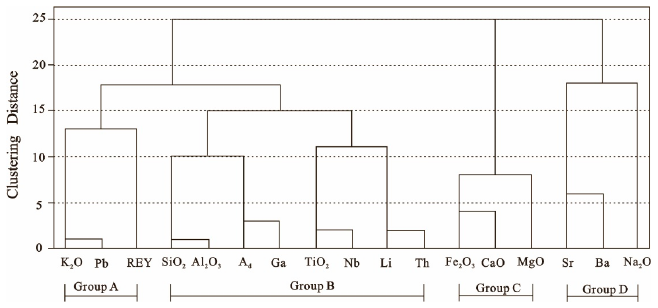
Figure 12. Cluster analysis diagram of elevated trace elements, ash yield, and selected major element oxides in the No. 2 1 coal. (cluster method, centroid clustering; interval, Pearson correlation; transform values, maximum magnitude of 1).